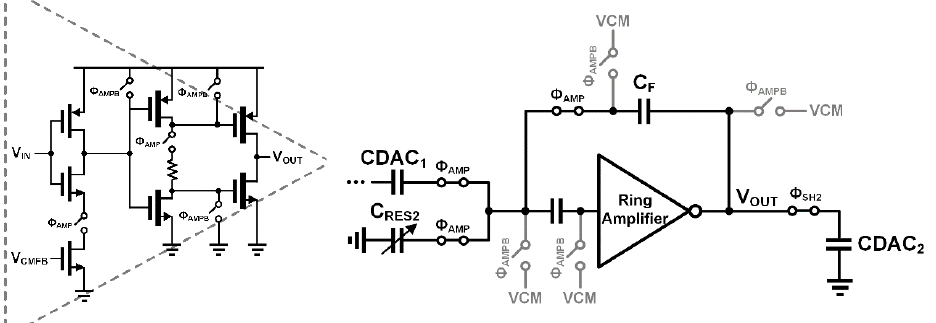
Figure 9. Structure of ring amplifier and multi-input inter-stage amplifier based on ring amplifier.